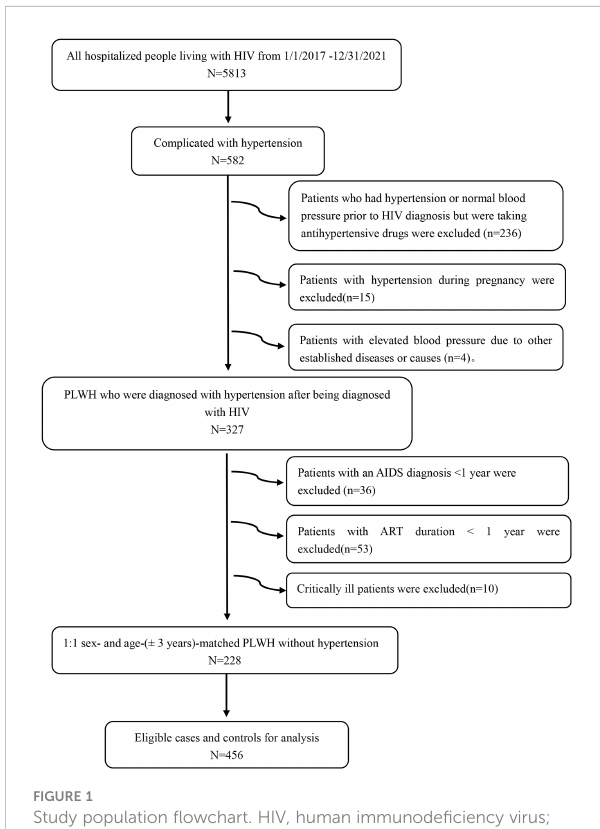
FIGURE 1 Study population fl owchart. HIV, human immunode fi ciency virus; AIDS, acquired immune de fi ciency syndrome; ART, antiretroviral therapy; PLWH, people living with